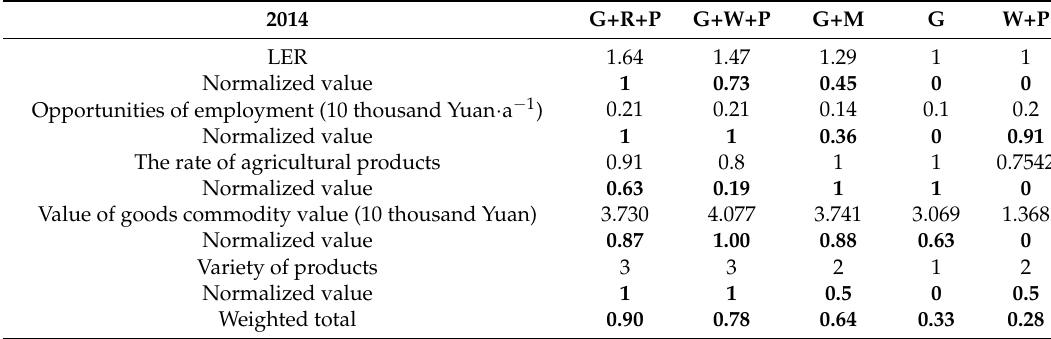
Table A6. Social indicator values from three mixed Ginkgo systems, pure Ginkgo (G), and a cropping system (W+P), 2014.